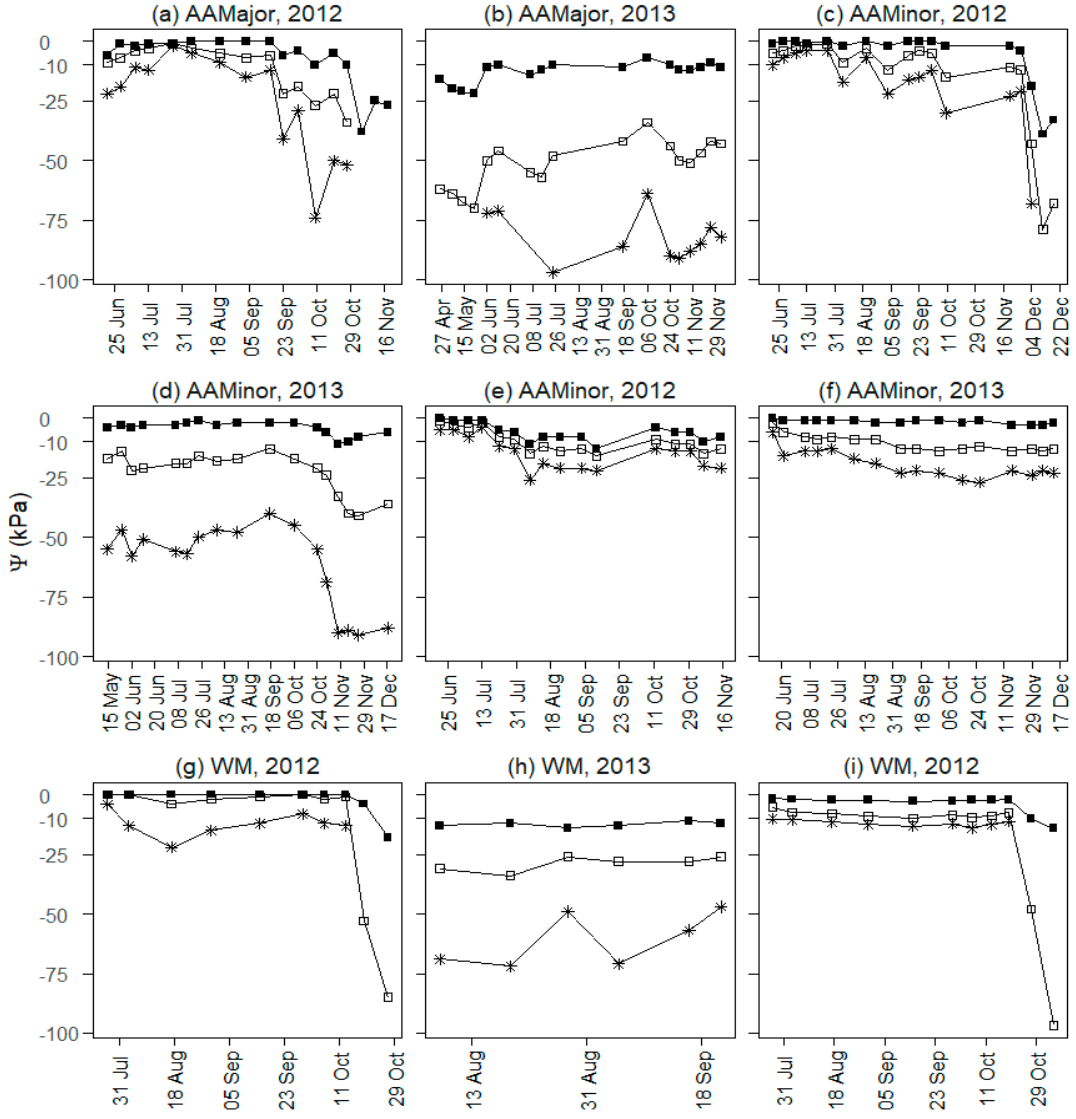
Figure 4. Average matric potential measured at three depths; 0.30 ( (cid:83) ), 0.60 ( (cid:3) ), and 0.80 m ( (cid:4) ) using watermark sensors in selected farmers’ fields AA and WM sites. The growing period of the crops is indicated at the top of each plot.